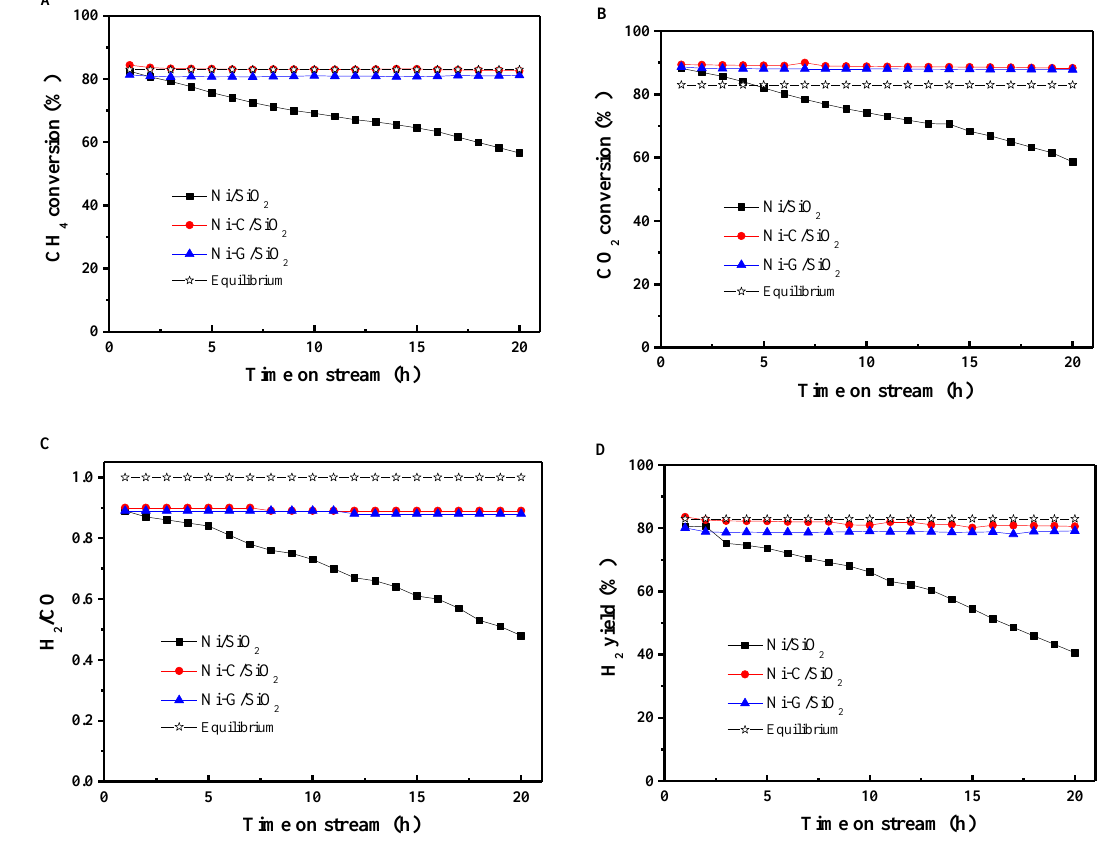
Figure 4. Time-on-stream CH4 conversion ( A ), CO2 conversion ( B ), H2/CO ( C ), and H2 yield ( D ) over catalysts under the conditions of P = 1.0 atm, T = 750 °C, CH4/CO2 = 1.0, and GHSV = 60,000 mL·g−1·h−1.